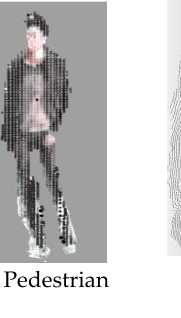
Figure 13. Five types of objects segmented from Scene A and B.